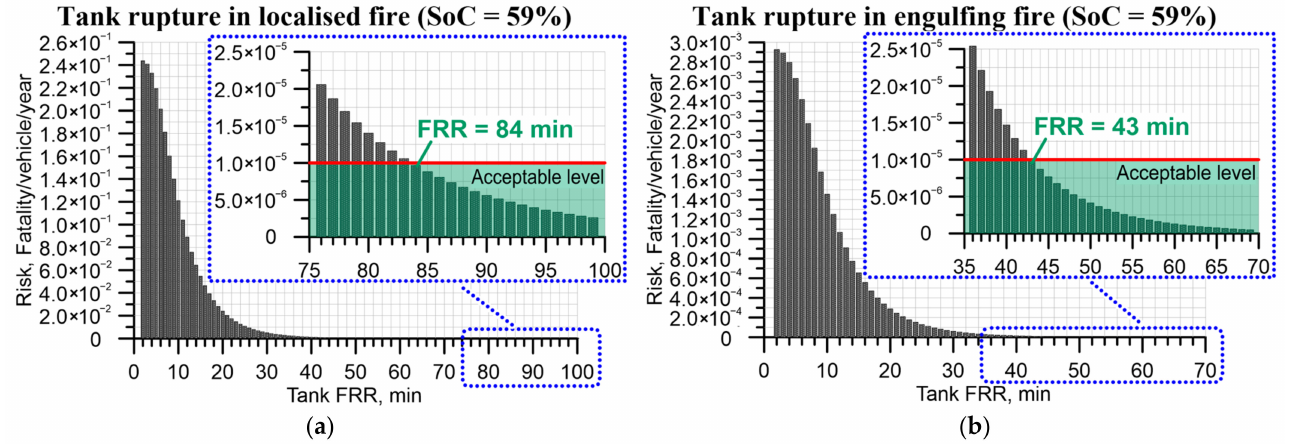
Figure 4. Risk (fatality/vehicle/year) as a function of hydrogen storage tank FRR for 62.4 L tank rupture at SoC = 59%: localised fire ( a ) and engulfing fire ( b